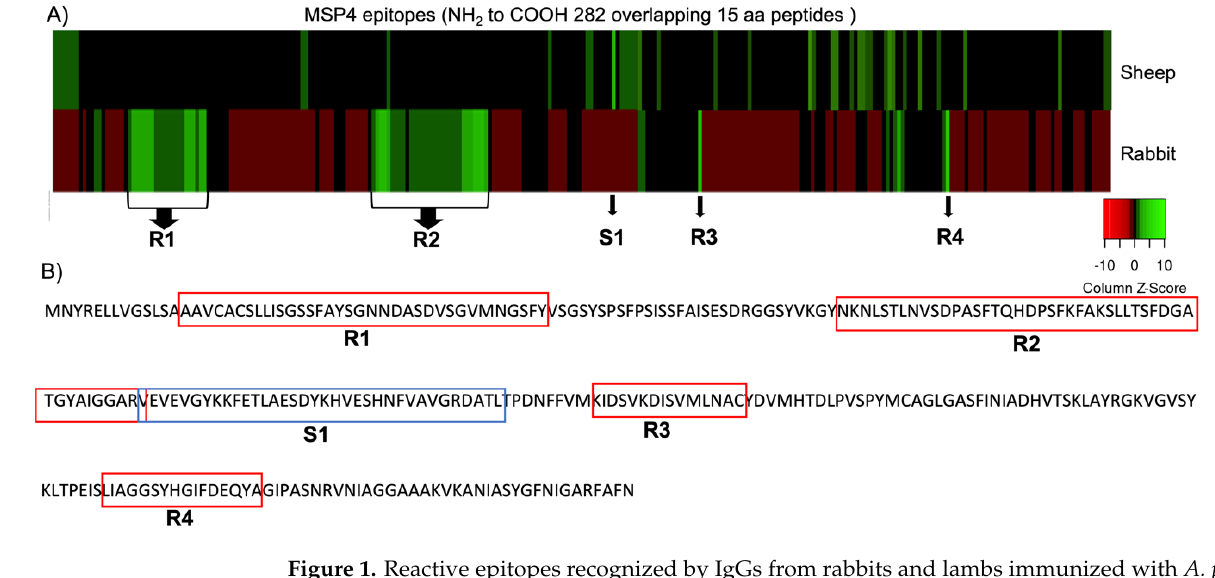
Figure 1. Reactive epitopes recognized by IgGs from rabbits and lambs immunized with A. phagocytophilum MSP4. ( A ) heatmap of the IgG reactive epitopes in rabbit and sheep. Peptides with significant Z-Score are indicated with R1 to R4 if they were recognized by rabbit IgG and S1 by sheep IgG; ( B ) reactive epitopes in MSP4 protein sequence. Red boxes indicate the epitopes recognized by rabbit IgG, and the blue box indicates an epitope recognized by sheep IgG. Reactive epitopes showed signal intensities with Z-score > 2.